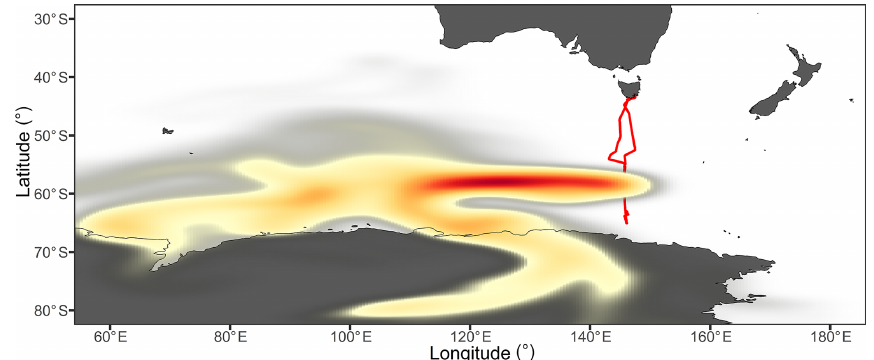
Figure 10. Probability distribution of air mass coordinates throughout all back-trajectory ensembles from the cAA-II sampling period. The colour scale reflects the proportion of trajectories which passed through each location, with the highest density of trajectories found in the dark red region. The ship’s voyage track is represented in red and the ship was located at a mean latitude of 59 ◦ S during this